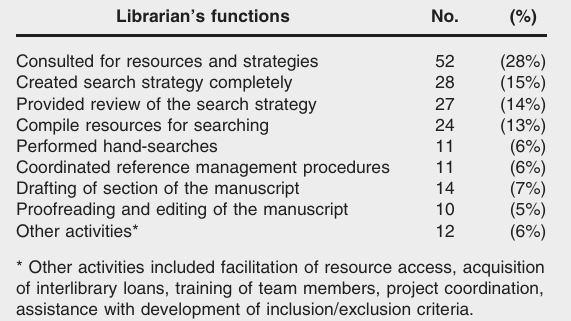
Table 2. Of note, 57% reported that the librarian had more than 1 function.